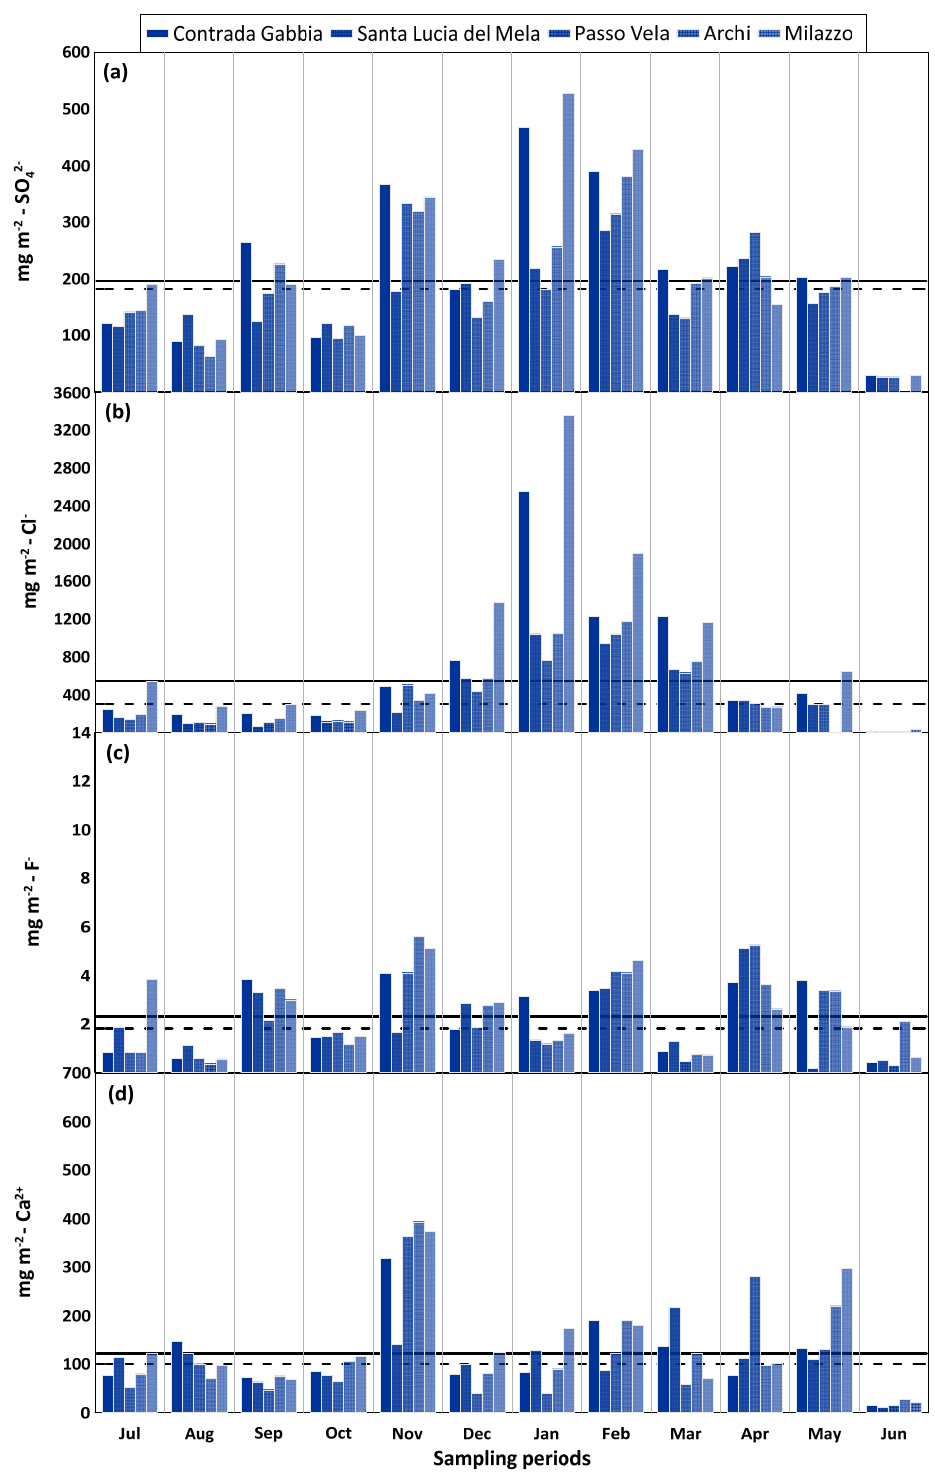
Figure 12. Monthly atmospheric depositions (mg m − 2 ) for sulphate ( a ), chloride ( b ), fluoride ( c ), and calcium ( d ) at Milazzo AERCA. The solid black lines are average values; the dashed lines are median values.